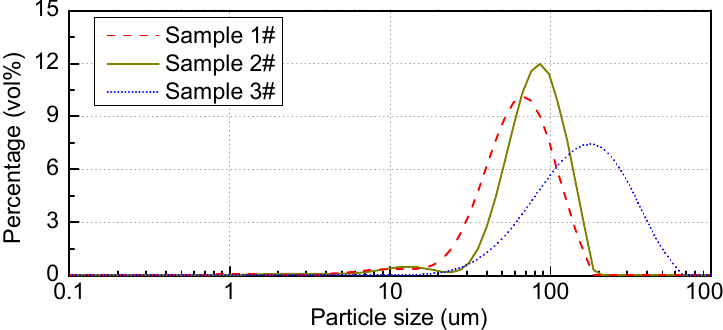
Figure 1. The particle size distribution curves of samples #1, #2, and #3.